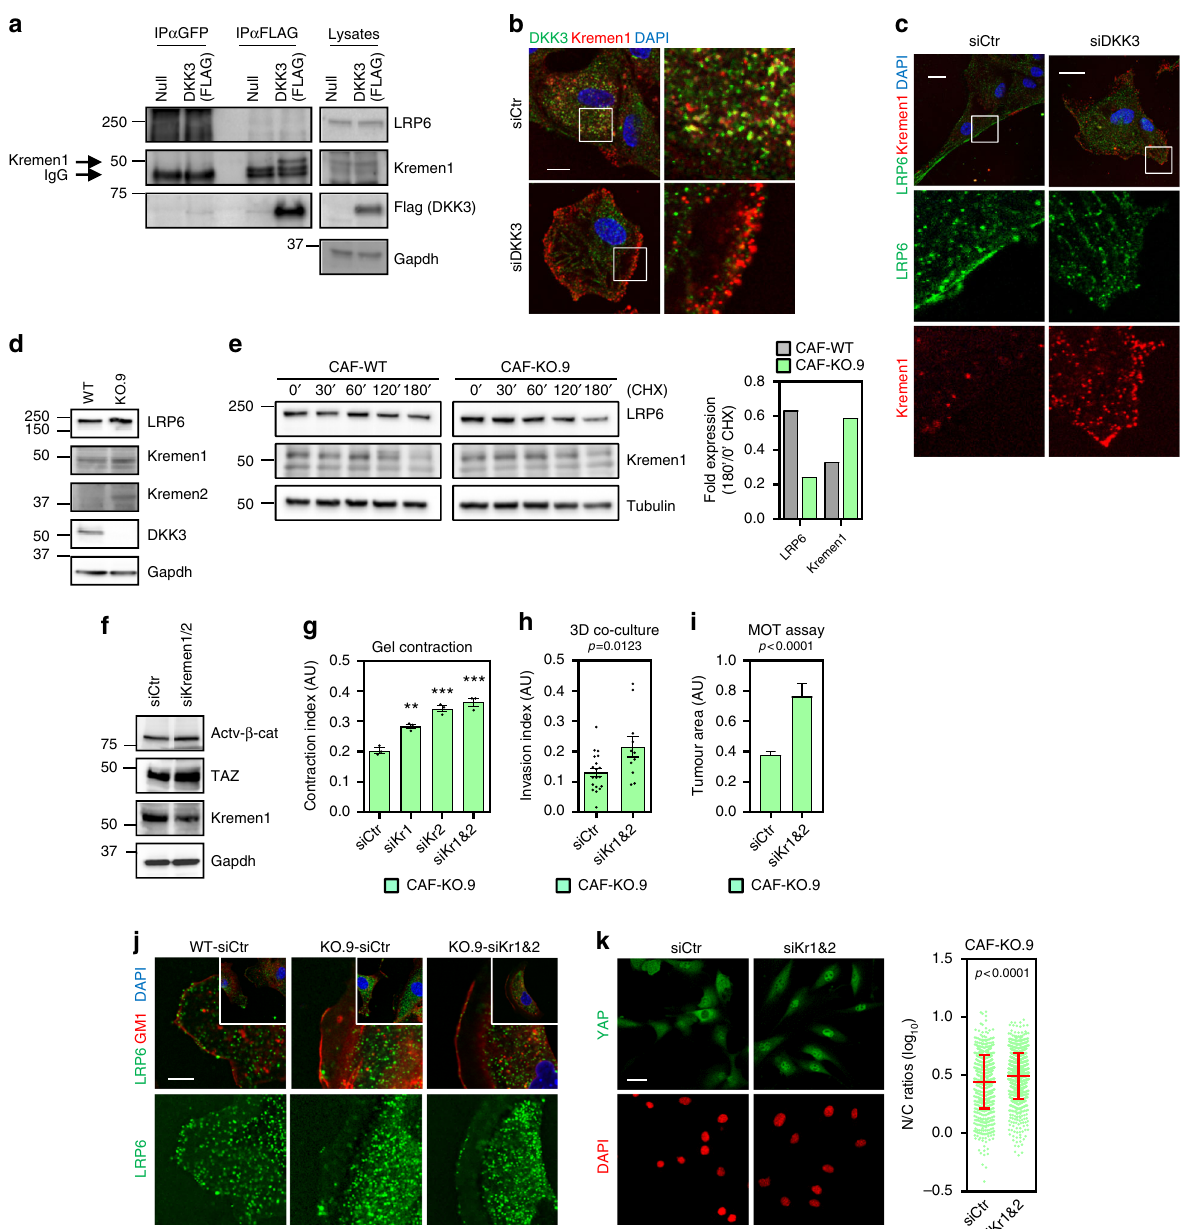
Fig. 8 DKK3 regulates the balance between LRP6 and Kremen and affects YAP/TAZ signalling. a Western blots show anti-Flag co-immune-precipitation of LRP6 and Kremen1 in human BC-CAFs (TB147) expressing Flag-DKK3 or empty vector (null). b Images show DKK3 (green), Kremen1 (red) and DAPI (blue) staining of human BC-CAF TB165 after transfection with control (siCtr) and DKK3 siRNA (smart-pool). Scale bars, 15 µ m. c Images show LRP6 (green), Kremen1 (red) and DAPI (blue) staining of human BC-CAF TB165 transfected as in ( b ). Scale bars, 15 µ m. d Western blots show LRP6, Kremen1, Kremen2, DKK3 and Gapdh expression in WT and KO.9 CAFs. e Western blots show LRP6, Kremen1 and tubulin expression in indicated CAFs after treatment with 100 μ g mL − 1 cyclohexamide (CHX) at different times (in min). Graph represents quanti fi cation of the indicated blots (normalised to tubulin) at 180 min relative to the amount at 0 min. f Western blots show non-phospho (active) β -catenin (Ser33/37/Thr41), TAZ, Kremen1 and Tubulin CAF-KO.9 after transfection with control (siCtr) and Kremen1&2 siRNA (smart-pool). g Graph shows gel contraction of KO.9 CAFs after transfection with control (siCtr), Kremen1 (siKr1), Kremen2 (siKr2) or Kremen1&2 (siKr1&2) siRNAs (smart-pool). Bars represent mean ± SEM ( n = 4 or more individual gels). h Graph shows the invasion index of TS1 spheroids after 3D co-culture with KO.9 CAFs transfected as in ( f ). Bars represent mean ± SEM ( n = 11 or more individual spheroids, 2 independent experiments). i Graph shows the tumoral area of TS1 MOT co-culture with KO.9 CAFs transfected as in ( f ). Bars represent mean ± SEM ( n = 348 or more colonies, at least 3 independent experiments). j Images show LRP6 (green), GM1 (red) and DAPI (blue) staining of indicated CAFs. Cells were fi xed and subjected to staining without permeabilisation. Scale bar, 15 μ m. k Images show YAP (green) and DAPI (red) staining of KO.9 CAFs transfected as in ( f ). Bar, 30 µ m. Graph shows quanti fi cation of nuclear relative to cytosolic fl uorescent intensity (log 10 ratios) of YAP. Lines represent mean ± SEM. For all graphs, * P < 0.05; ** P < 0.01; *** P < 0.001; # P < 0.0001; n.s., non-signi fi cant